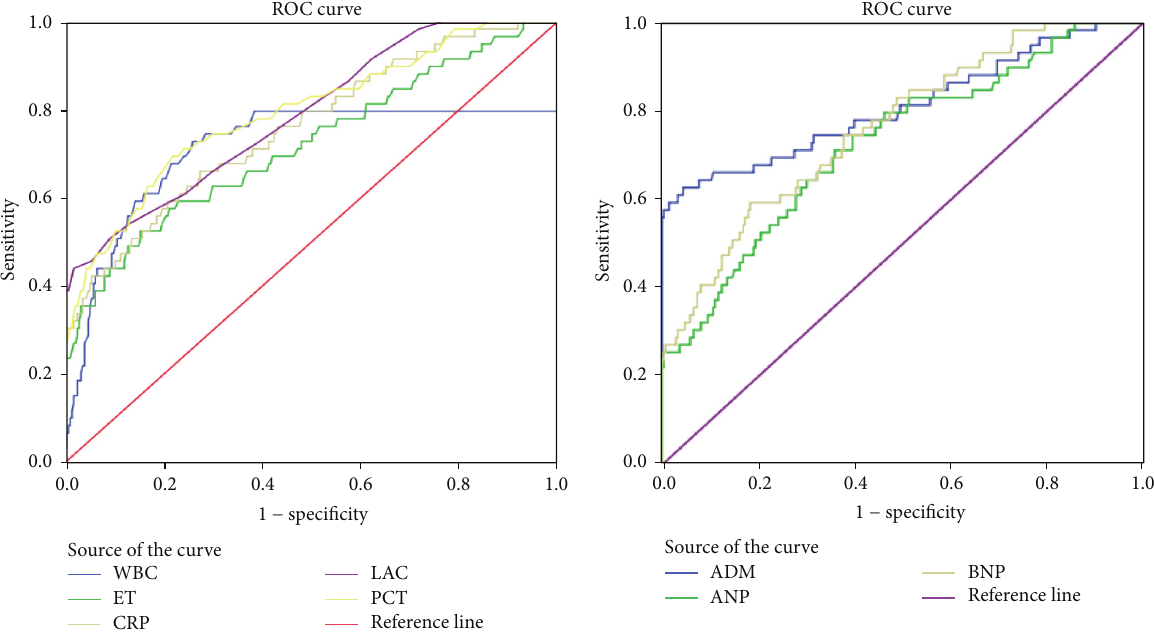
Figure 3: The ROC curves of ET, WBC, CRP, LAC, PCT, ADM, ANP, and BNP for predicting URS-induced urosepsis in UUO patients.